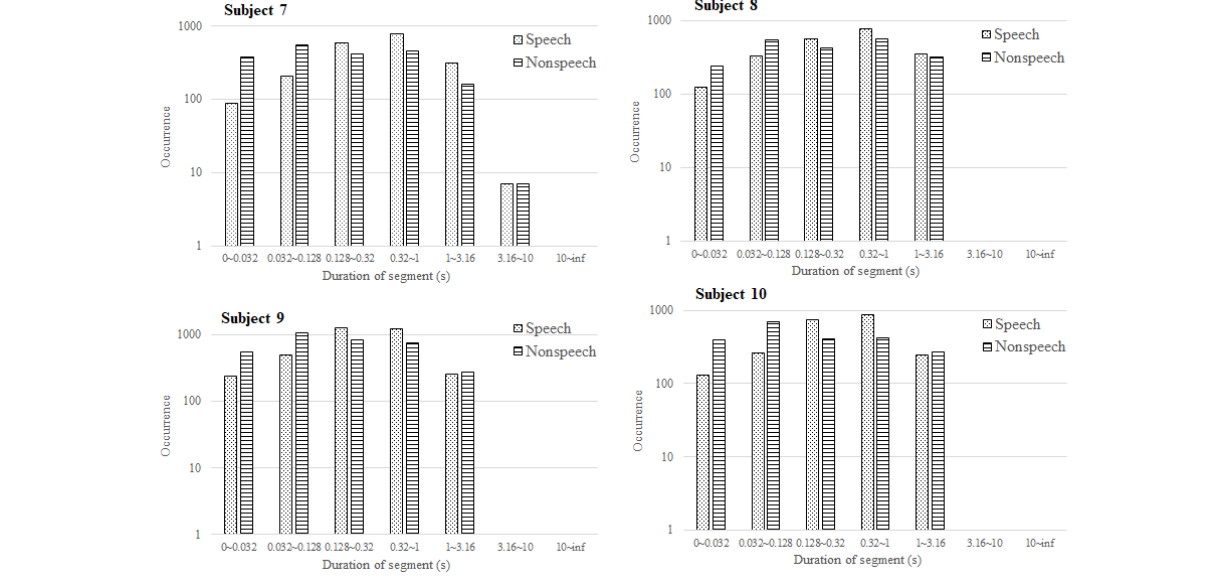
Figure 7. Speech and nonspeech segments measured by the automatic speech detection system. The x-axis indicates the length of the speech segments in a logarithmic scale, while the y-axis represents the occurrences during the recording period in a logarithmic scale (Subjects